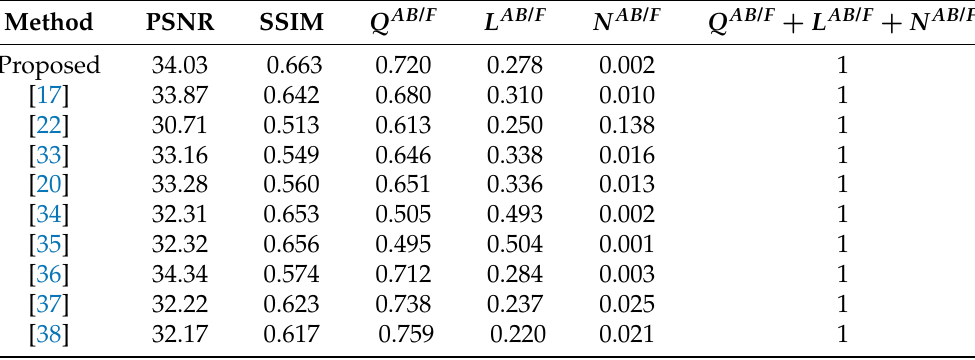
Table 1. Average PSNR, SSIM, Q AB / F , L AB / F and N AB / F indices of different